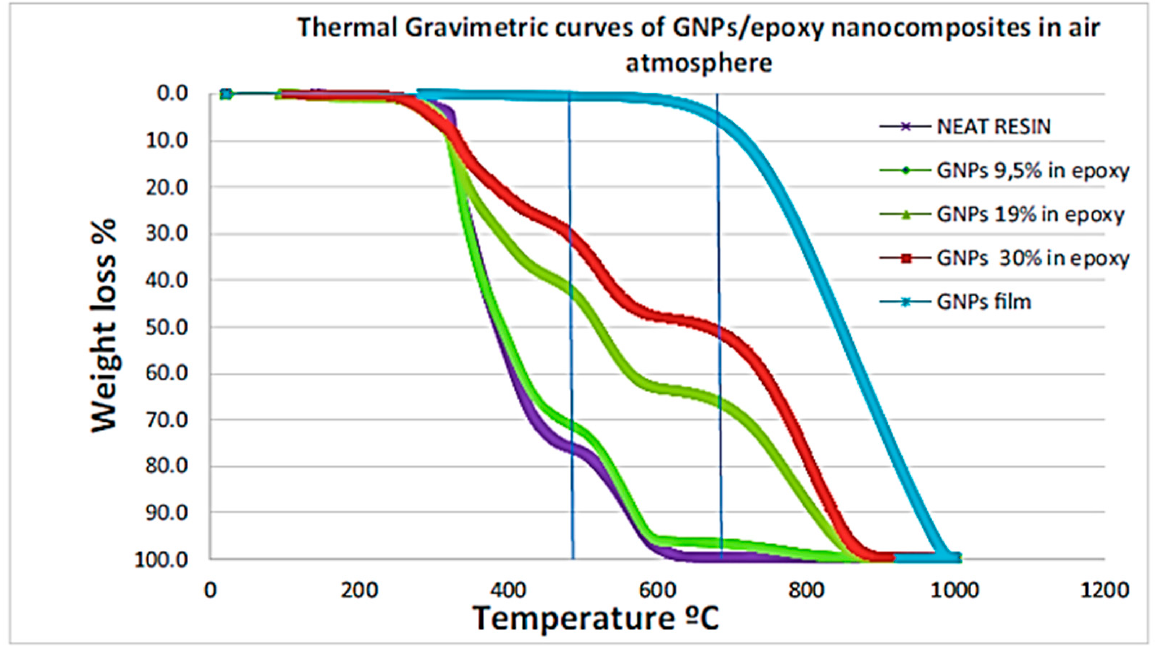
Figure 5. Thermogravimetric curves of graphene nanoplatelets/epoxy (GNPs/epoxy) nanocomposites in air. Reprinted with permission from [104]. 2020, Springer.